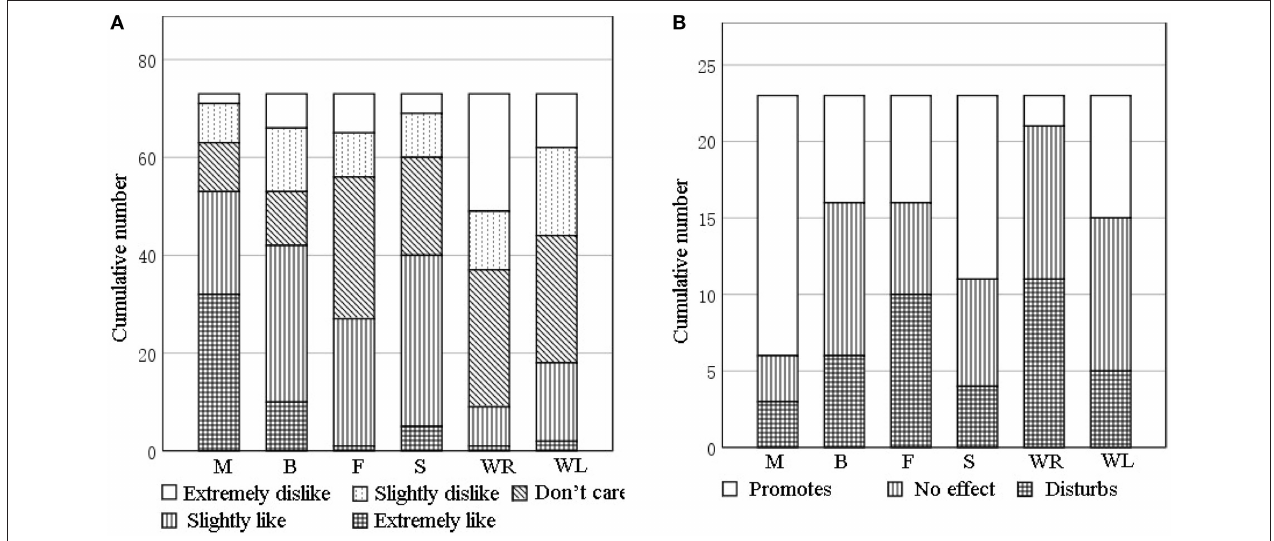
FIGURE 1 | (A) Sound type preferences of older adults with dementia. (B) Evaluation of the effect of each sound type on care partners on activity engagement; M, Music; B, Birdsong; F, Fountain; S, Stream; WR, wind and rain; and WL, wind blowing leaves.